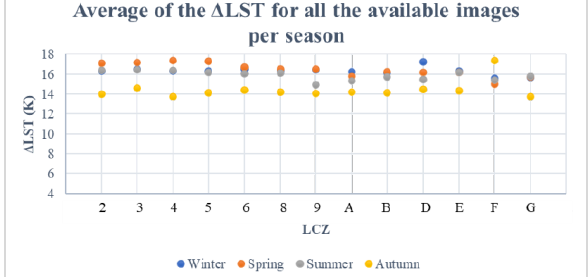
Figure 7 . Mean LST per LCZ and season from all MODIS data available.